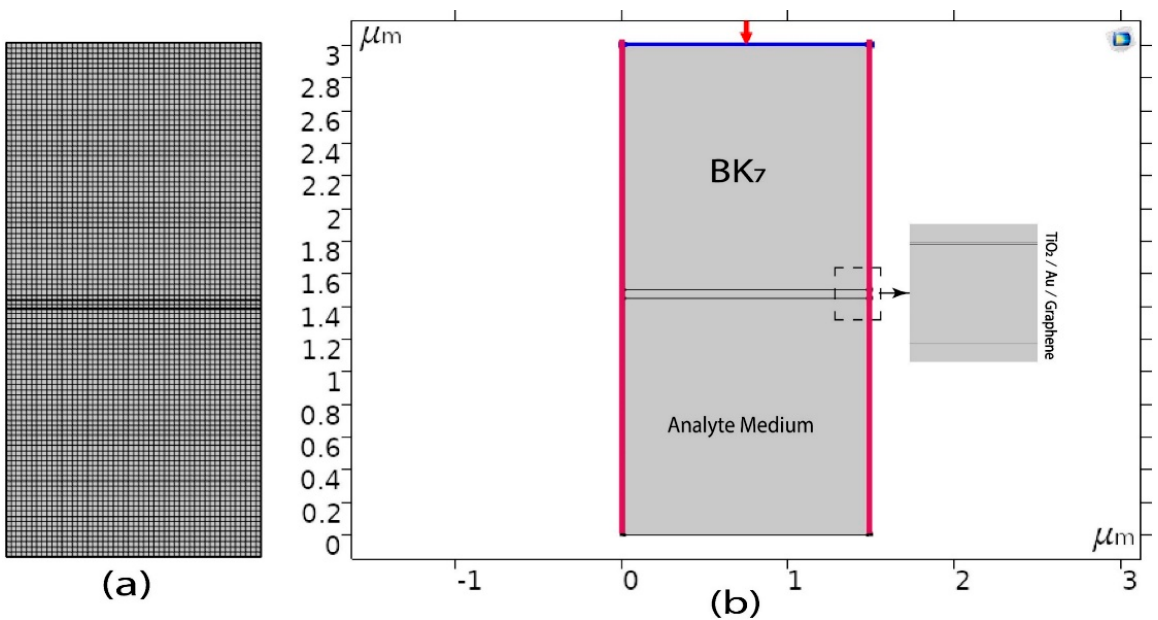
Figure 2. General COMSOL Multiphysics view structure of the proposed (BK 7 /TiO 2 /Au/graphene) SPR biosensor. ( a ) Computational meshing domain. ( b ) Numerical simulation model of the pro- posed structure.